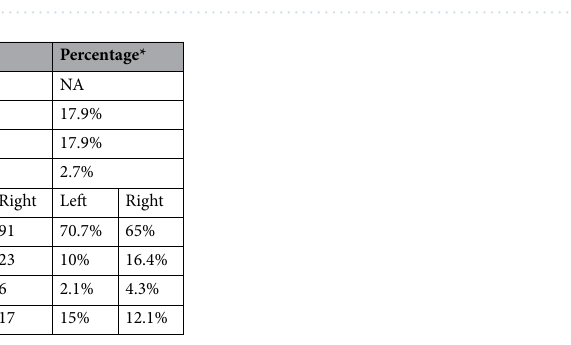
Table 2. Findings during physical examination (n = 140). *Percentage over total SBI population (n = 140). NA = Not applicable. Missing values for capsule type = 17L, 3R; BMI = 7.